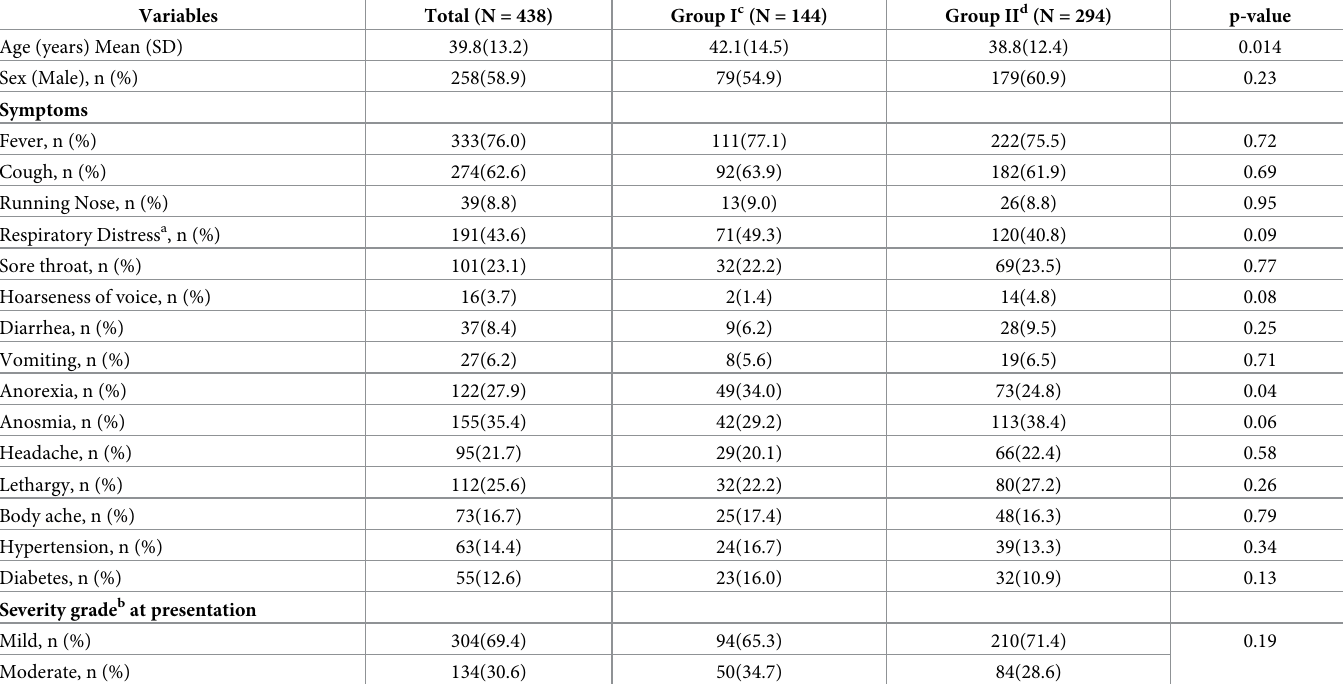
Table 1. Baseline characteristics of COVID-19 patients with different blood groups (N = 438).